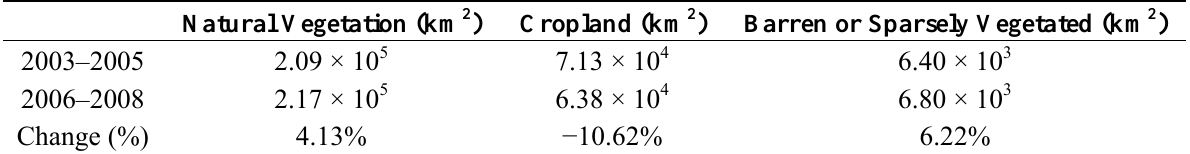
Table 3. Land cover change shown by three-year-summarized MODIS land cover data.